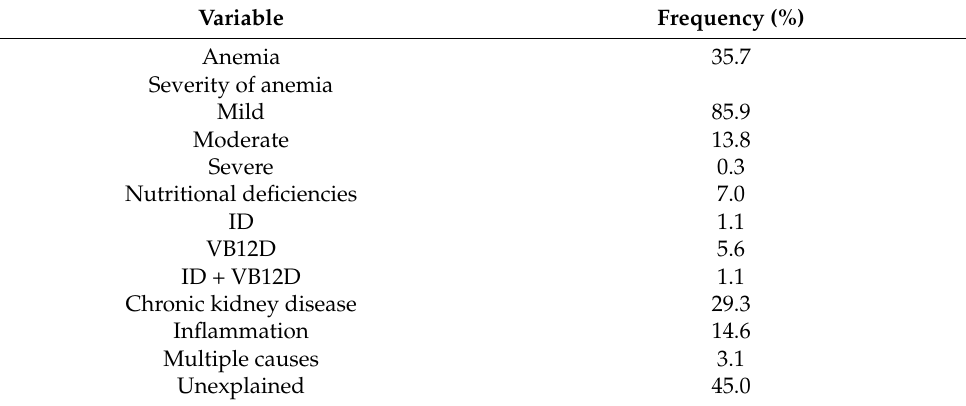
Table 2. Severity of anemia and contributions of possible causal factors in older adults.